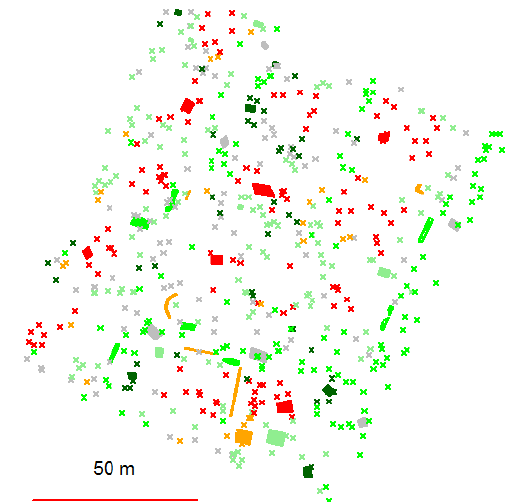
Figure 1. Training areas and randomly selected checkpoints (crosses). The colours represent different